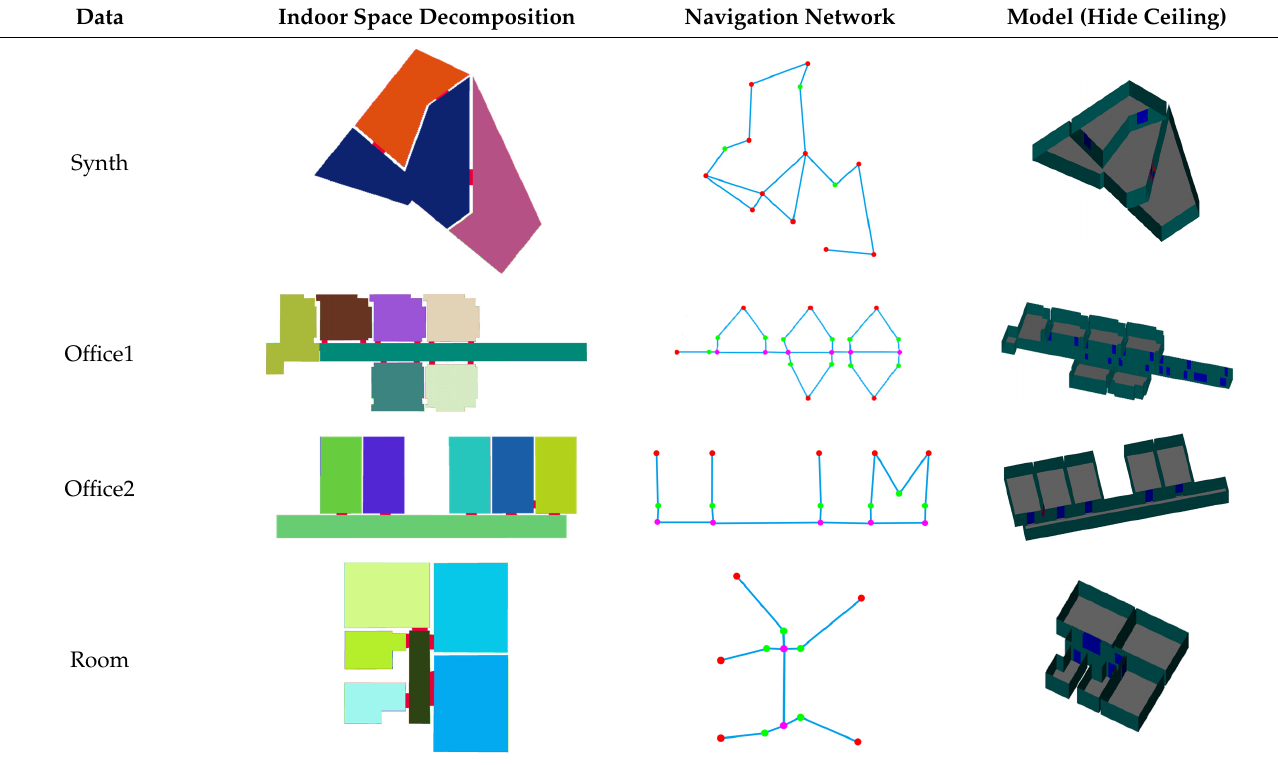
Table 2. Model reconstruction and navigation network generation results.